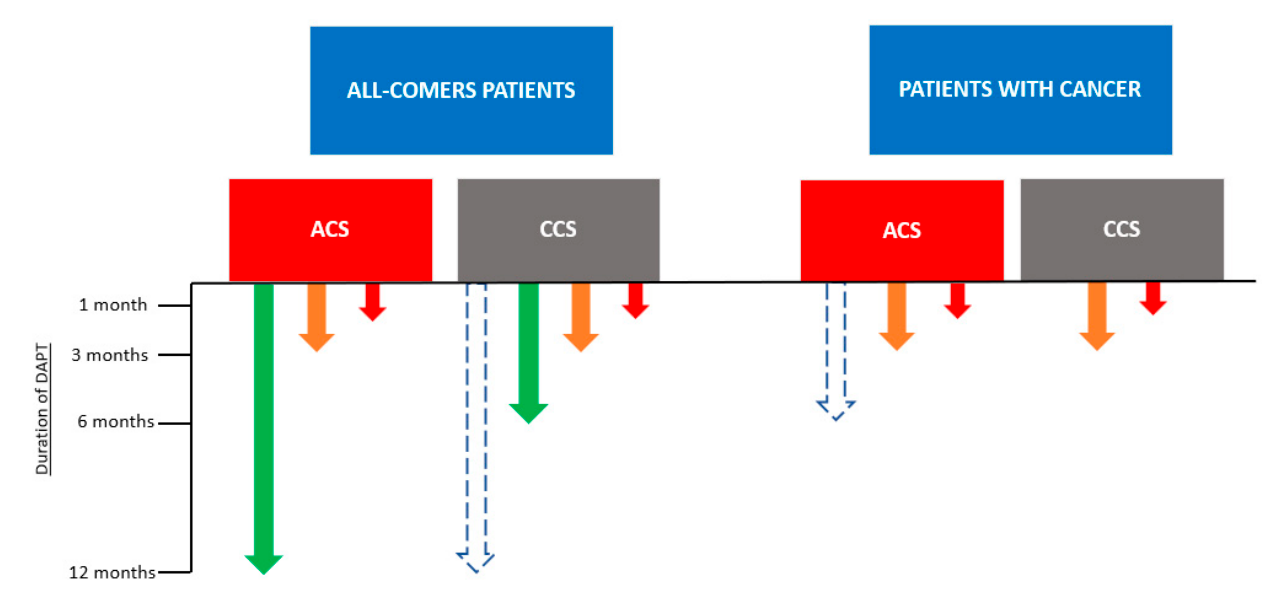
Figure 2. Strategies regarding the duration of DAPT after elective PCI and ACS in all-comers and cancer patients.